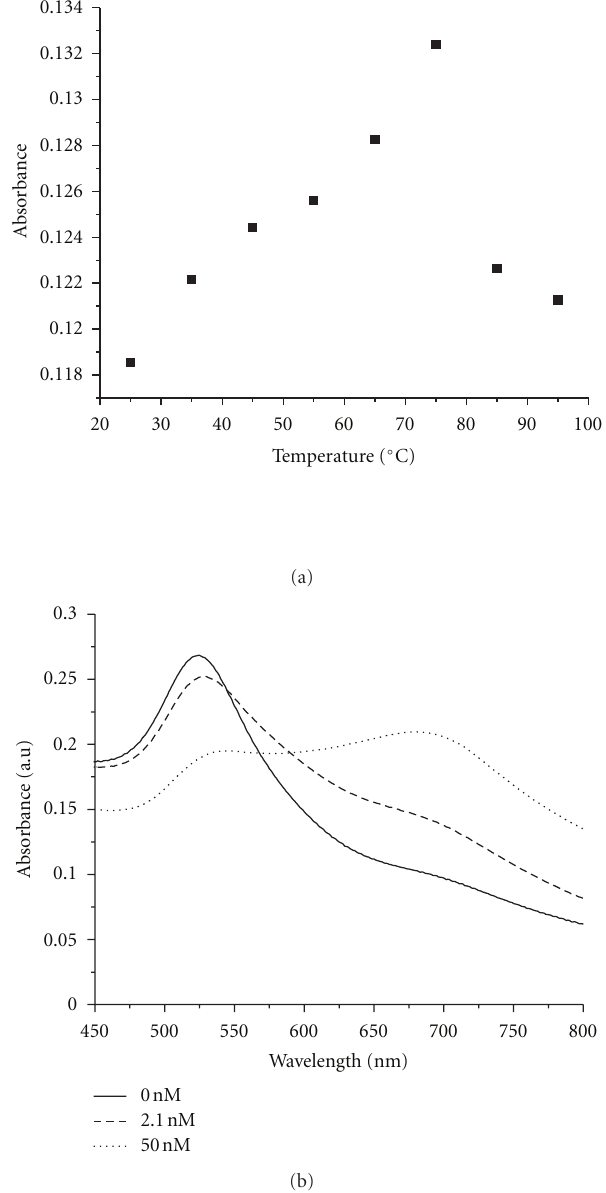
Figure 2: (a) Relationship between gold nanoparticle absorption intensity at 740 nm and temperature. An increase in intensity is observed from 25 ◦ C to 75 ◦ C, followed by a decrease; (b) change in absorption spectrum of gold nanoparticles as a function of 17mer DNA